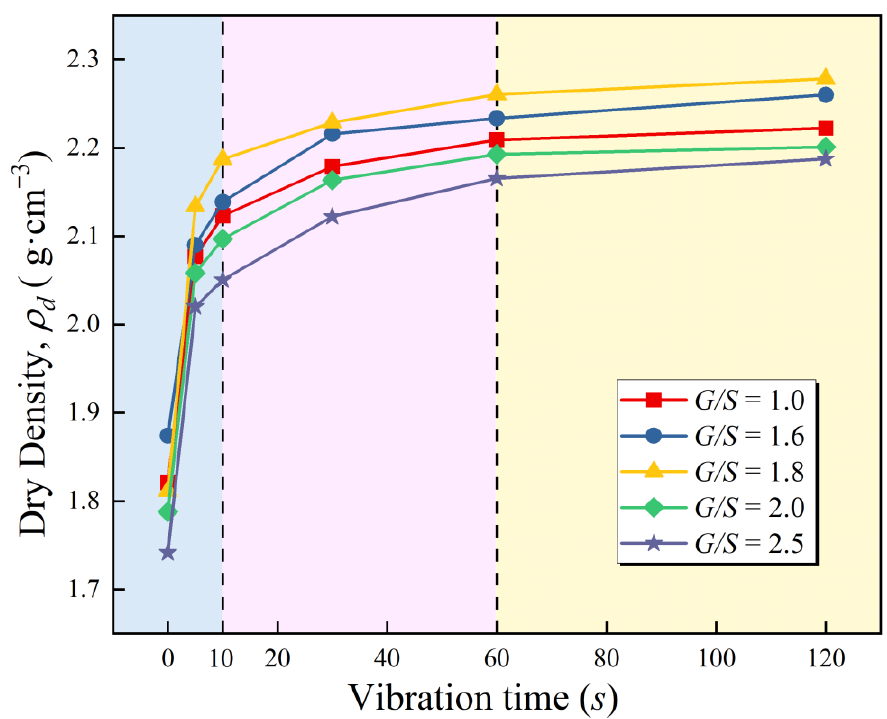
Figure 6. The curves of achieved dry density versus elapsed time from newly plate vibratory compaction tests.